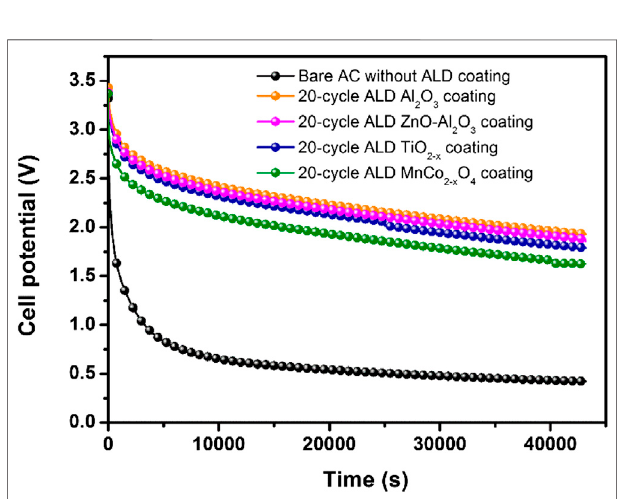
FIGURE 8 | Self-discharge pro fi le of bare AC electrodes without ALD coating and with various ALD oxide coating of 20-cycle.